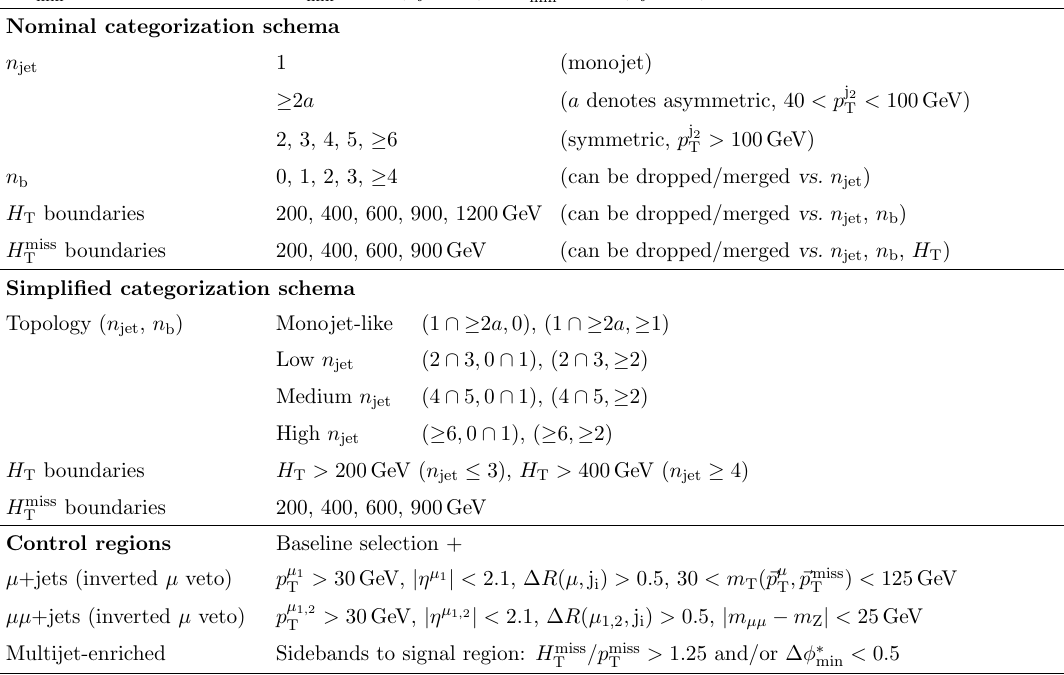
Table 1 . Summary of the physics object acceptances, the baseline event selection, the signal and control regions, and the event categorization schemas. The nominal categorization schema is de(cid:12)ned in full in appendix